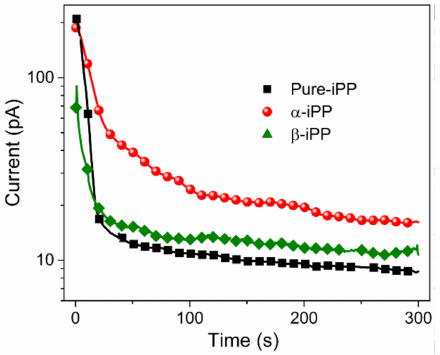
Figure 7. DC conduction current of iPP samples at room temperature.